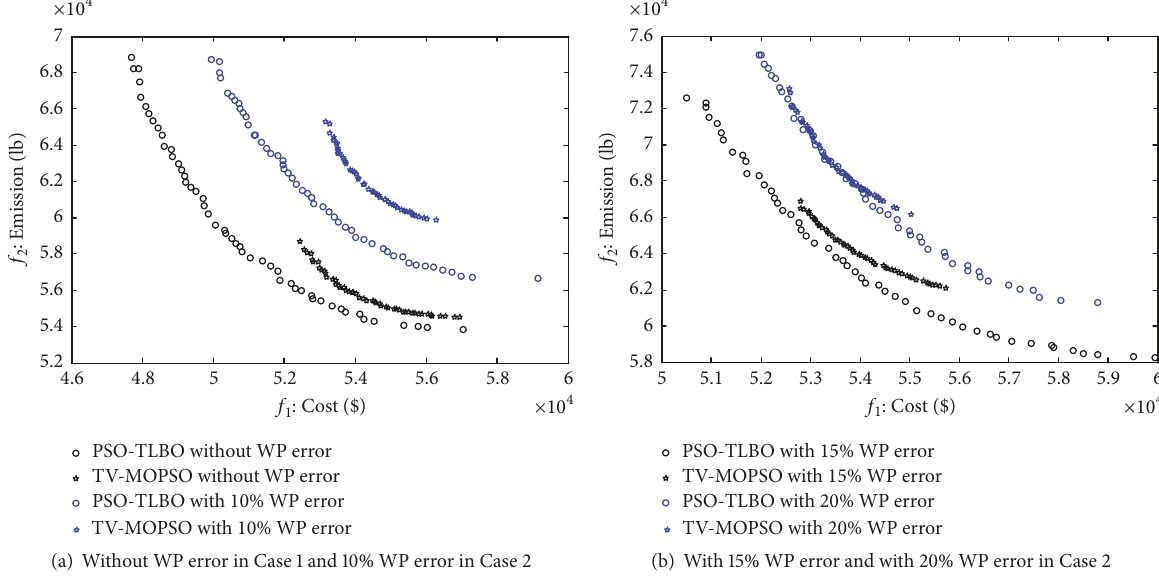
Figure 9: Pareto fronts obtained using the PSO-TLBO and TV-MOPSO in Cases 1 and 2.